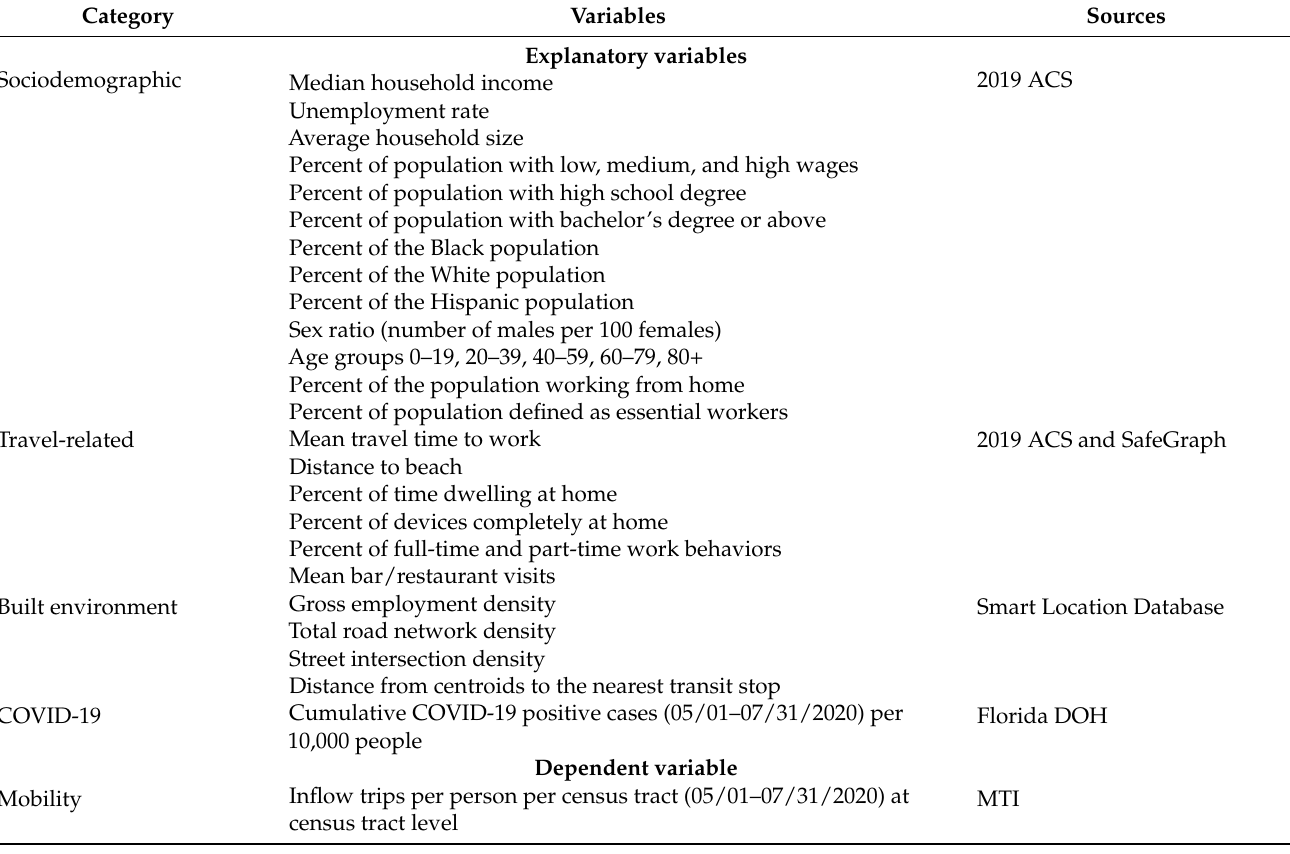
Table 3. Explanatory variables and the dependent variable used in this